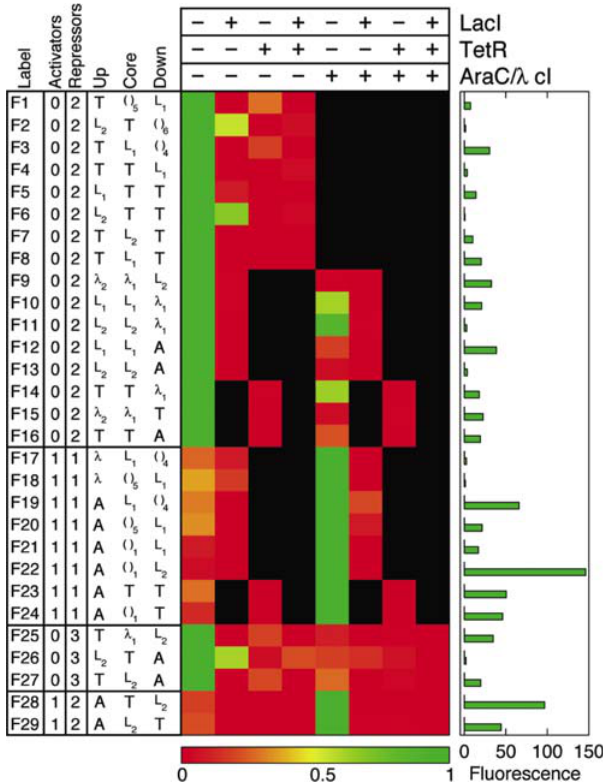
Figure 3. Promoter architectures and transcriptional logic phenotypes of the forward-designed promoter library. Rows represent different promoter architectures (F1–F29). The two columns labeled ‘Activators’ and ‘Repressors’ indicate the number of distinct activators and repressors capable of binding each promoter. Columns labeled ‘Up’, ‘Core’, and ‘Down’ indicate the three specific DNA fragments coding for various operators (see Fig. 2 for fragment sequences). Parentheses indicate a sequence lacking TR binding sites. For each promoter architecture, gene expression levels are represented by fluorescence measured for individual clones grown in eight wells corresponding to all eight different conditions of binding/nonbinding ( + / 2 ) of LacI (L), TetR (T), and AraC/ l cI (A/ l ). For clarity, we show only the relevant growth conditions for each promoter (expression levels were dependent only on the presence/absence of regulator specific inducers). Fluorescence was determined at an optical density (600 nm) of 0.3. Each row is normalized to the minimum (‘0’, red) and maximum (‘1’, green) fluorescence values for that particular promoter, with the actual minimum and maximum values given in the accompanying histogram to the right (all minimum values were very low and consistent with control cells lacking the yfp